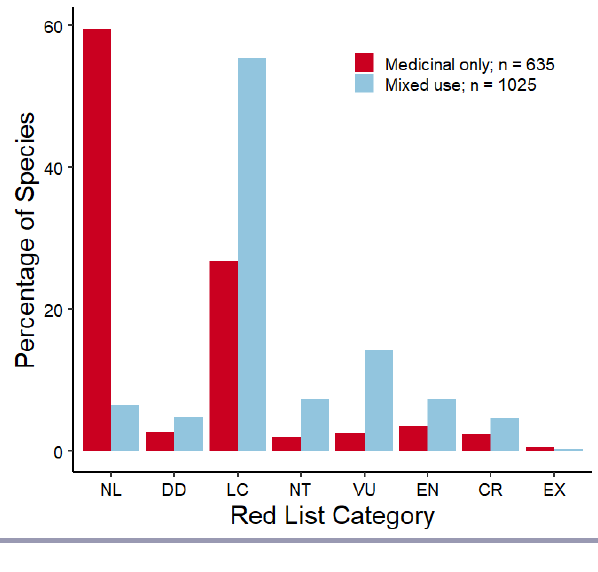
Fig. 3. Percentage of medicinal use species with medicinal